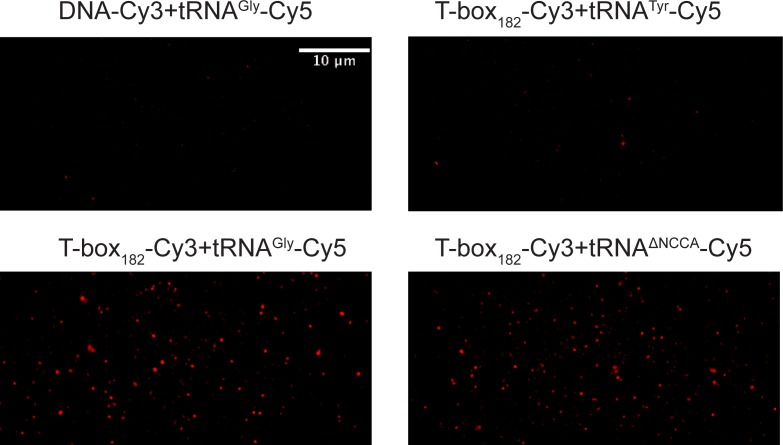
Representative images of smFRET data for T-box-Cy3(3’) and tRNA-Cy5 binding.Images were created by maximum intensity projection of Cy5 emission of the time-lapse images and therefore report on the binding events of tRNA-Cy5 to the surface tethered T-box. A DNA oligo labeled with Cy3 is used as a negative control for non-specific binding or signal. Loading tRNATyr-Cy5 to pre-immobilized T-box-Cy3(3’) only generates background level of Cy5 signals in the maximum intensity projection similar to the negative control, and these nonspecific Cy5 signals do not generate any smFRET traces.